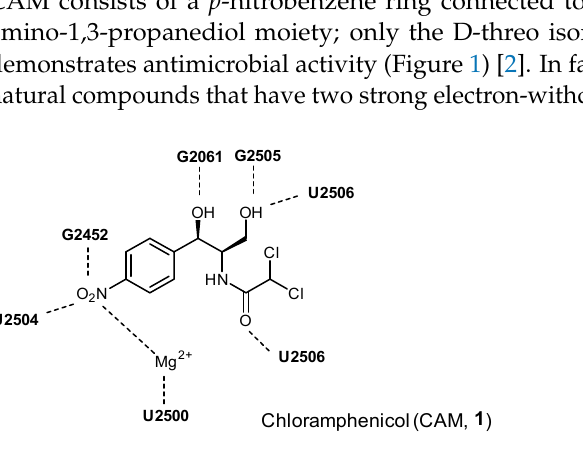
Figure 1. Structure of chloramphenicol and its interactions with the 23S rRNA nucleotides. CAM is a competitive translation inhibitor as its binding with the peptidyltransferase center (PTC) in the 23S rRNA of the 50S subunit of the bacterial ribosome prevents the interaction of an incoming aminoacyl moiety of an aminoacyl-tRNA substrate with the A site [3]. Both hydroxy groups of the antibiotic, as well as the carbonyl group of the dichloroacetamide residue, form a hydrogen bond with the 23S rRNA nucleotides (Figure 1) which results in the inhibition of the peptide bond formation